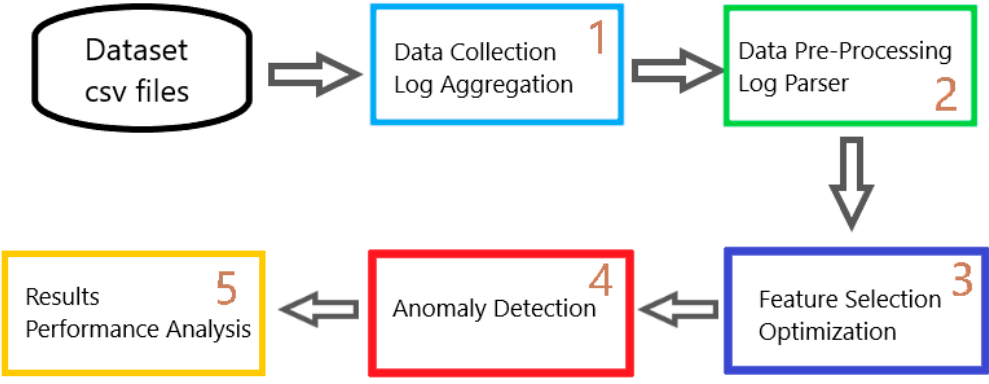
Figure 1. Diagram of proposed method and data flow inside the model.